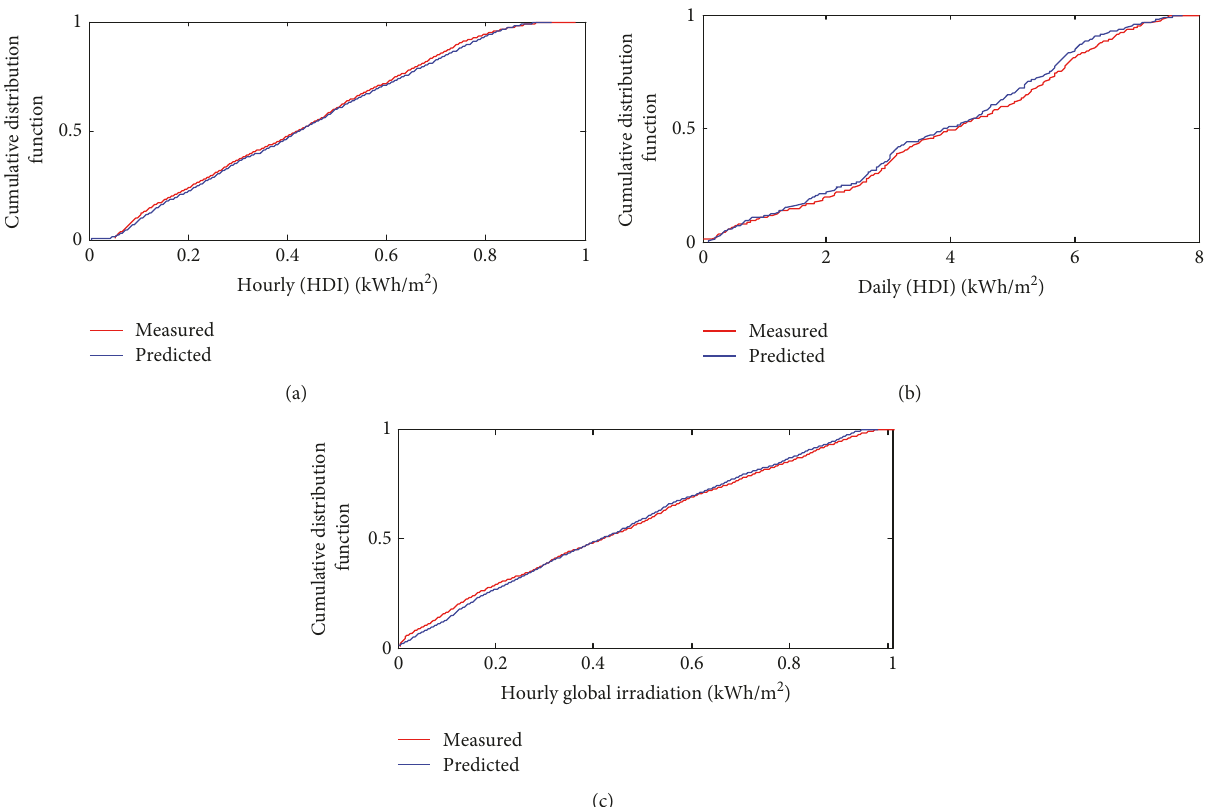
Figure 13: Cumulative distribution function between predicted and measured